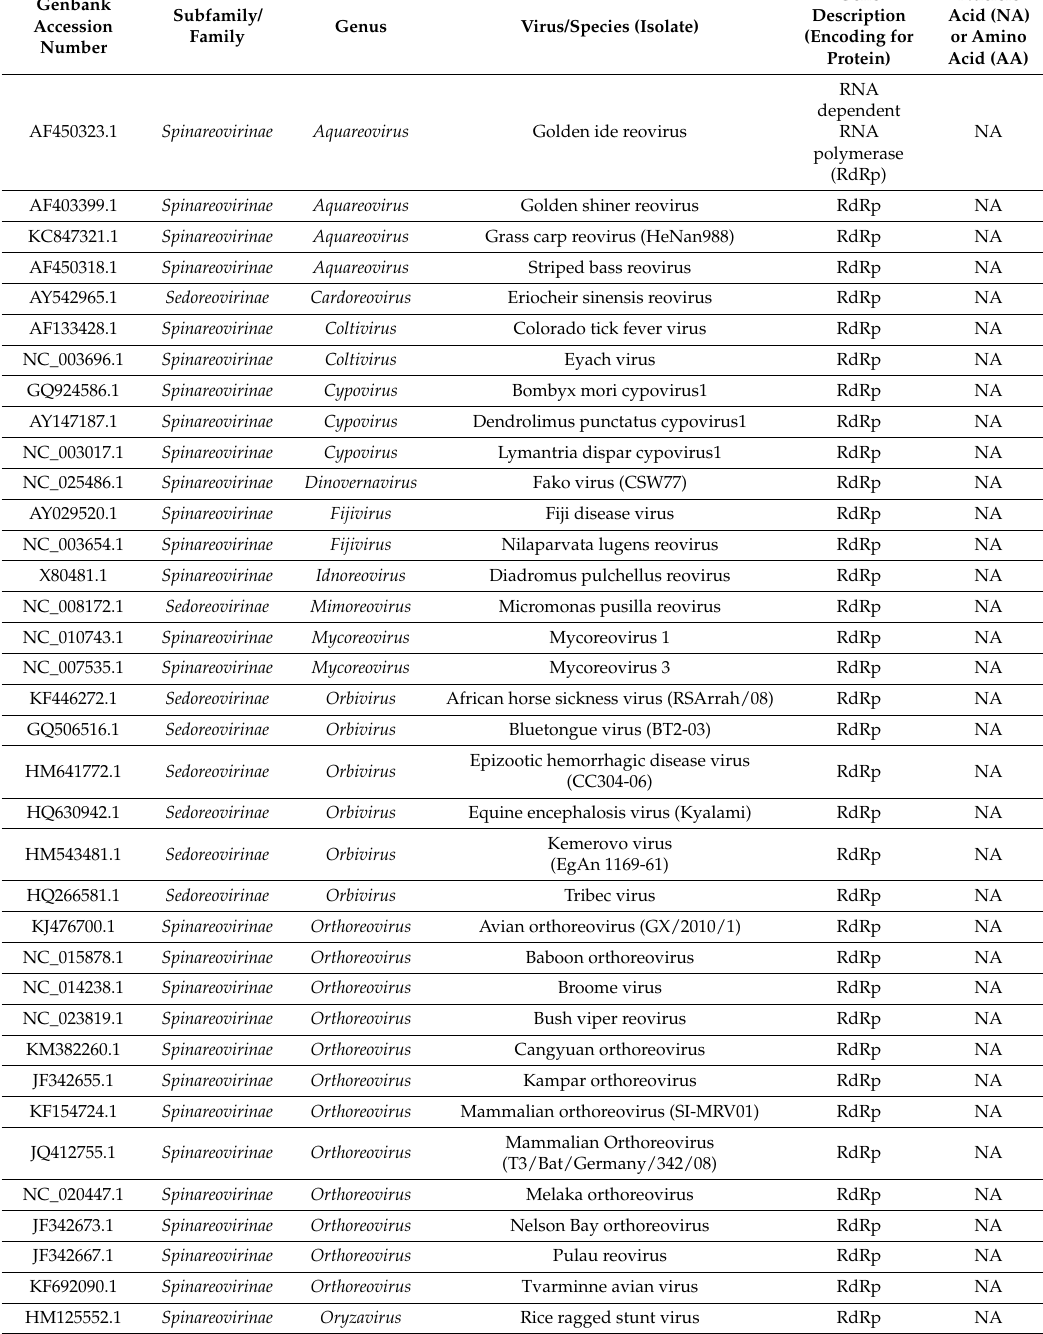
Table 1. Genbank accession numbers of sequences used for phylogenetic analysis in this